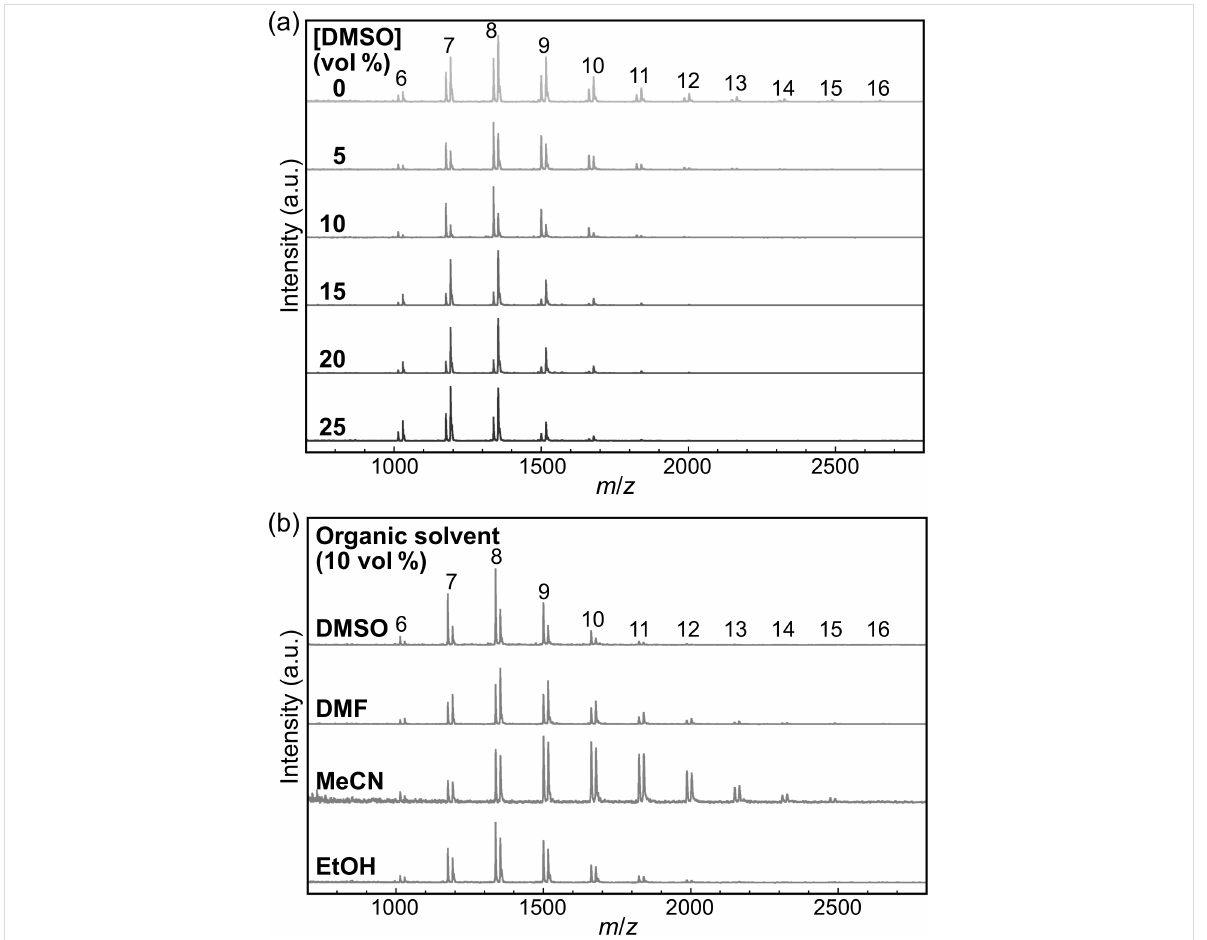
Figure 6: MALDI–TOF mass spectra of the products with (a) DMSO at various concentrations and (b) various organic solvents at 10 vol %. The numbers above the peaks denote the DP values of the cellulose oligomers. The spectra show two series of peaks corresponding to cellulose oligomers with sodium and potassium ion adducts.